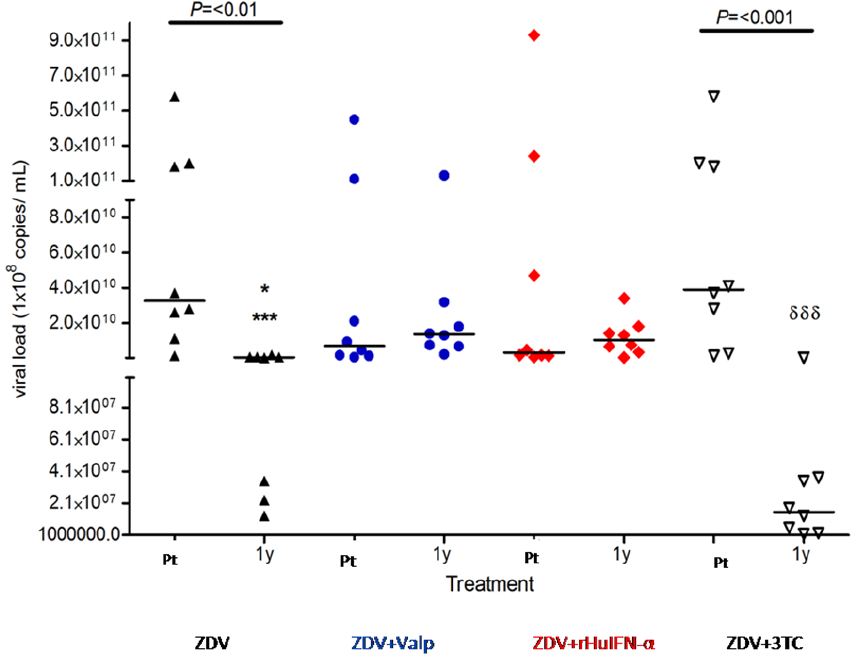
Figure 2. Viral load in cats treated with ZDV alone, or in combination with Valp, rHuIFN- α or 3TC. No significant differences were observed between the pre-treatment (Pt) values of each group. Significant differences were observed at one year (1y) of treatment for * ZDV vs. ZDV + 3TC (P = 0.03); *** ZDV vs. ZDV + Valp ( p < 0.001) or ZDV vs. vs. ZDV + rHuIFN- α ( p < 0.001). Intra-group analysis of pre-treatment vs. 1y values only revealed significant differences in the ZDV and ZDV + 3TC groups as indicated in the figure. Each dot represents one cat and values are expressed as median and range. Symbols: apex-up black triangles: ZDV as the sole drug; blue circles: ZDV + Valp; red diamonds: ZDV + rHuIFN- α ; apex-down white triangles: ZDV +